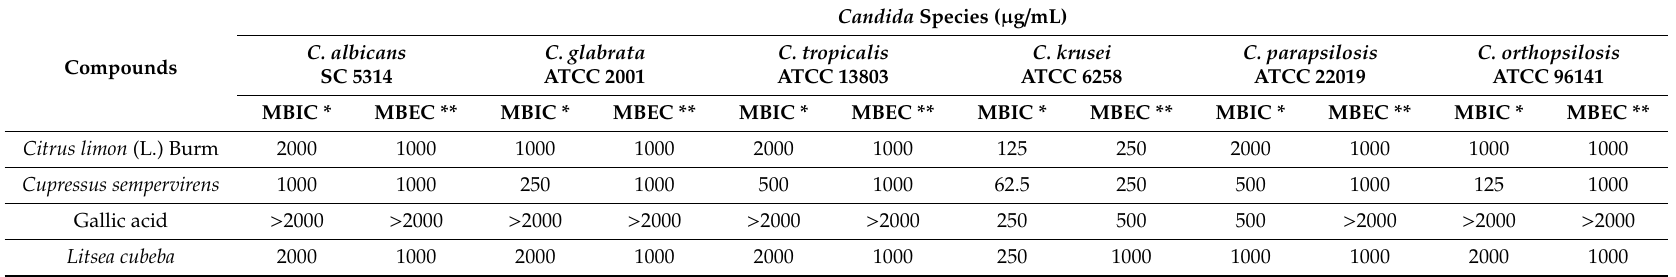
Table 5. Activity of the essential oils and gallic acid on biofilm formation and against preformed Candida species biofilms.